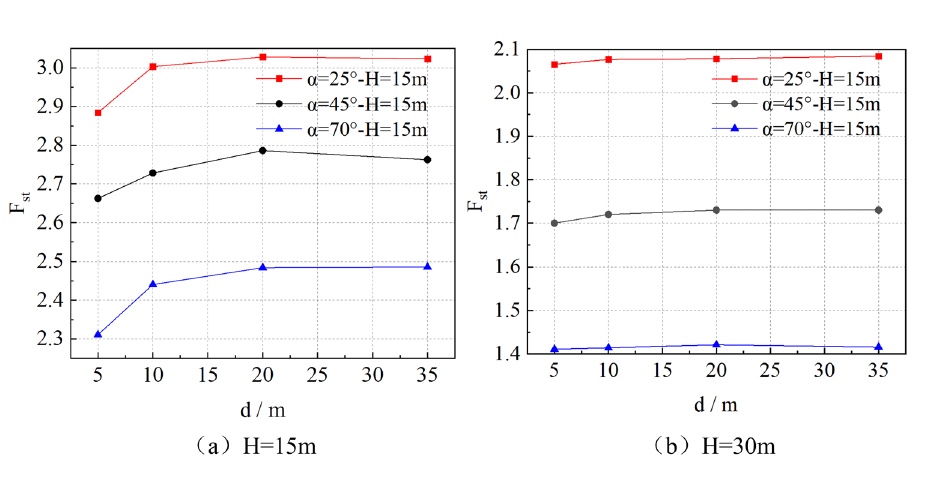
Figure 13. The safety of slope VS d